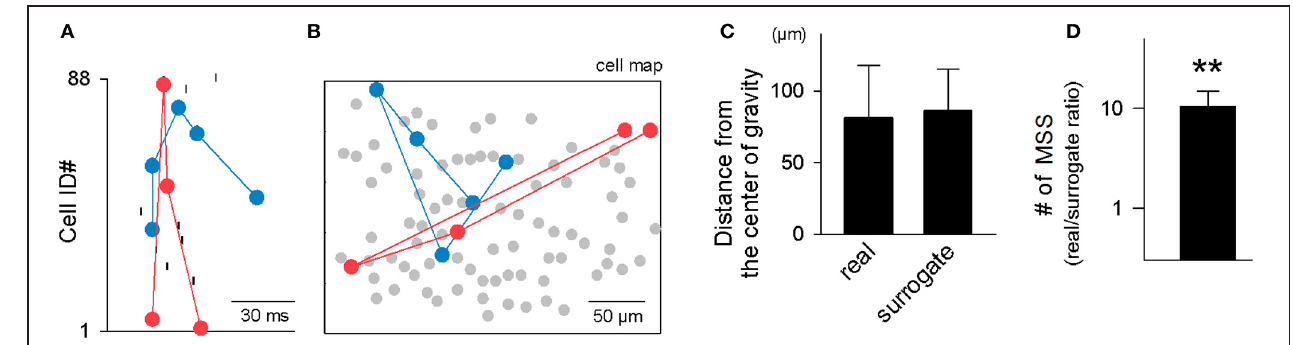
FIGURE 7 | Spatial dispersion of MSSs. (A,B) Two representative MSSs in a rastergram (A) and in a cell map (B) . (C) The mean Euclidean distance from individual cells that participated in a MSS to the center of gravity of all cells that participated in the MSS was compared surrogates in which the same number of cells in the original MSS were selected randomly from the same